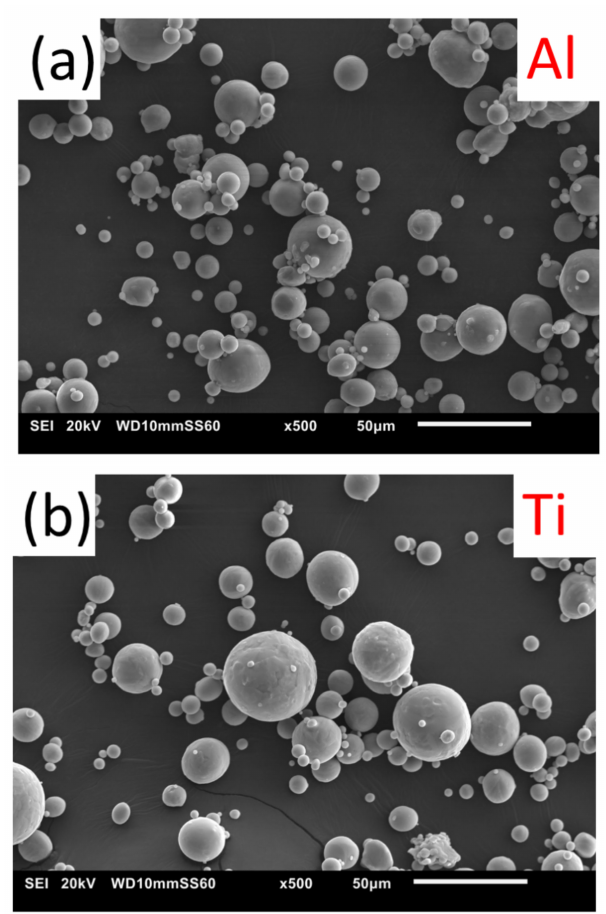
Figure 1. SEM images of Al ( a ) and Ti ( b ) feedstock powder used to produce WS